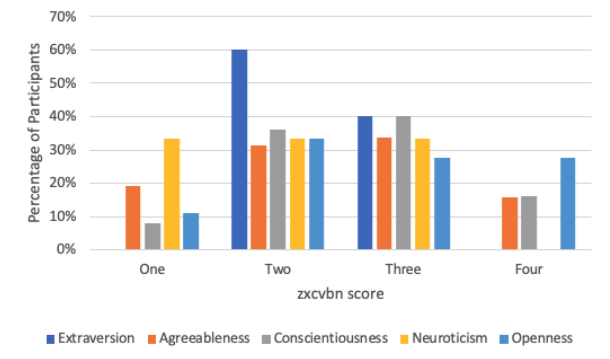
Figure 5. SONA survey: True Colors personality self-schemas and password strength according to zxcvbn.